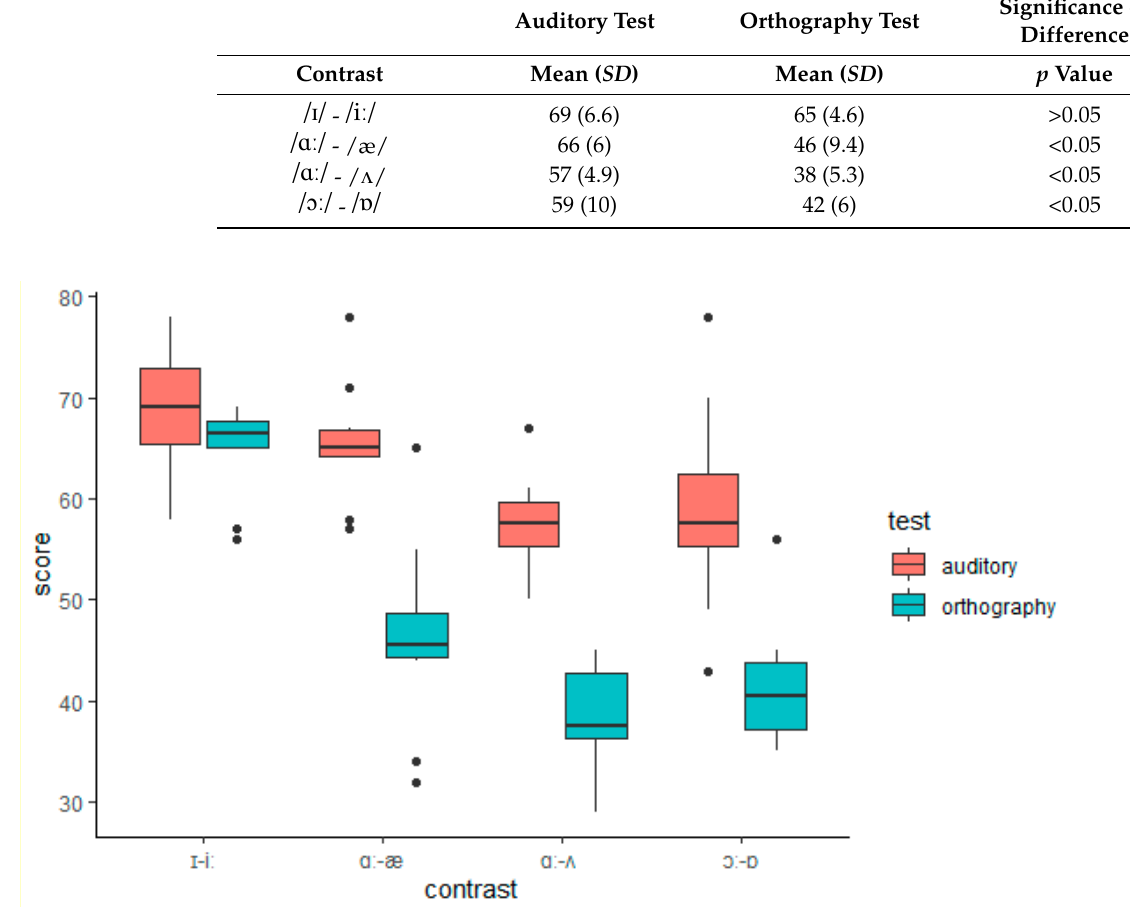
Table 1. Target English graphemes and phonemes and possible association of English graphemes with Greek phonemes by the Greek learners of English.